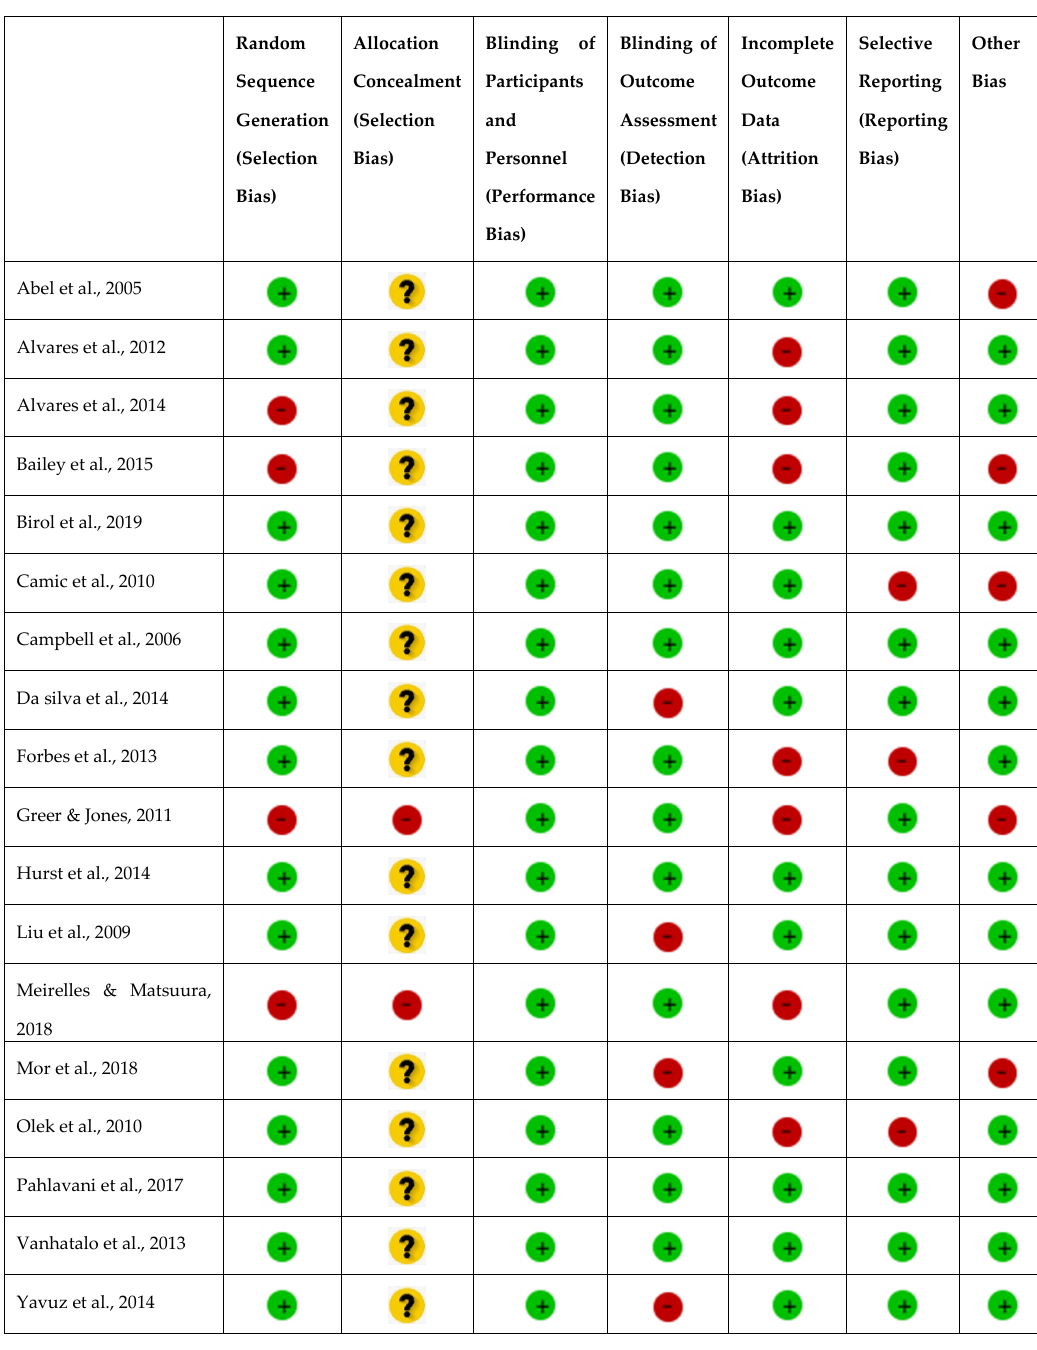
Figure 2. Summary of risk of bias: authors’ judgements about each risk of bias item for all included studies. indicate low risk of bias; indicate unknown risk of bias; indicate high risk of bias.